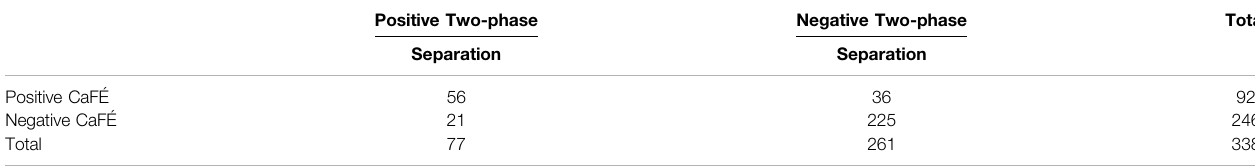
TABLE 2| Comparisonbetweenthetwo-phase separationmethodandconcentrationand fi ltrationelution(CaFÉ) methodfortheisolationofanySabin-likepoliovirus during theparallelandpilottests:Haïti(December2017 — December2019),Guatemala(November2018 — August2019),Thailand(February2019 — July2019),thePhilippines